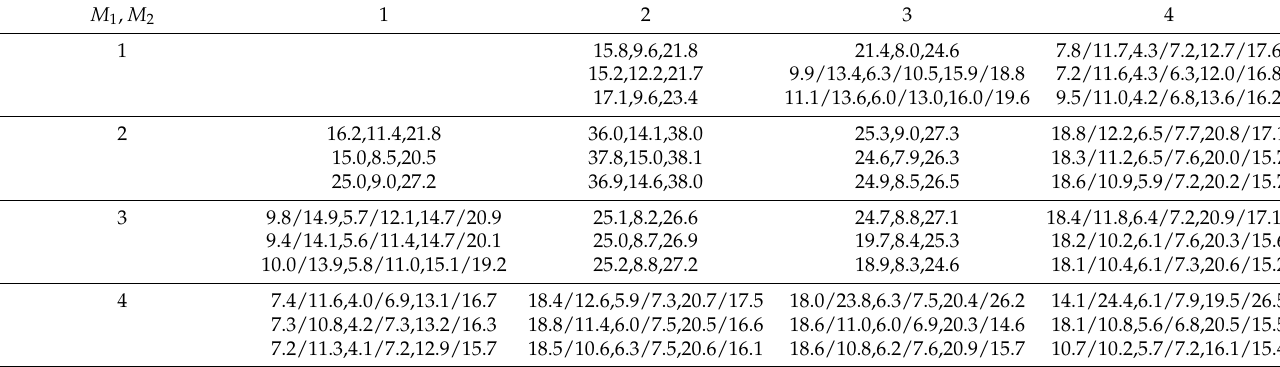
Table 1. Minimum energy spectrum decay (orders of magnitude) in the simulated regimes of spatial periods M 1 L and M 2 L in x 1 and x 2 , respectively. In each cell of the table, three lines show the decays in the runs for the three different initial conditions that are labelled by the suffices 1, 2 and 3 in the names of the runs (see the beginning of the present section). In each line, commas separate three groups of numbers showing the energy spectra decays of the flow, v , magnetic field, b , and the difference, θ , between the temperature and the linear temperature profile for the fluid at equilibrium in the respective run. A single number in a group, or the first number in a group of two numbers refers to the value in the run with the standard resolution of 128 M 1 × 128 M 2 × 97 harmonics. The second number (after the slash) in a group of two numbers refers to the decay in the alternative resolution run involving 256 × 256 × 257 harmonics, when such runs have been